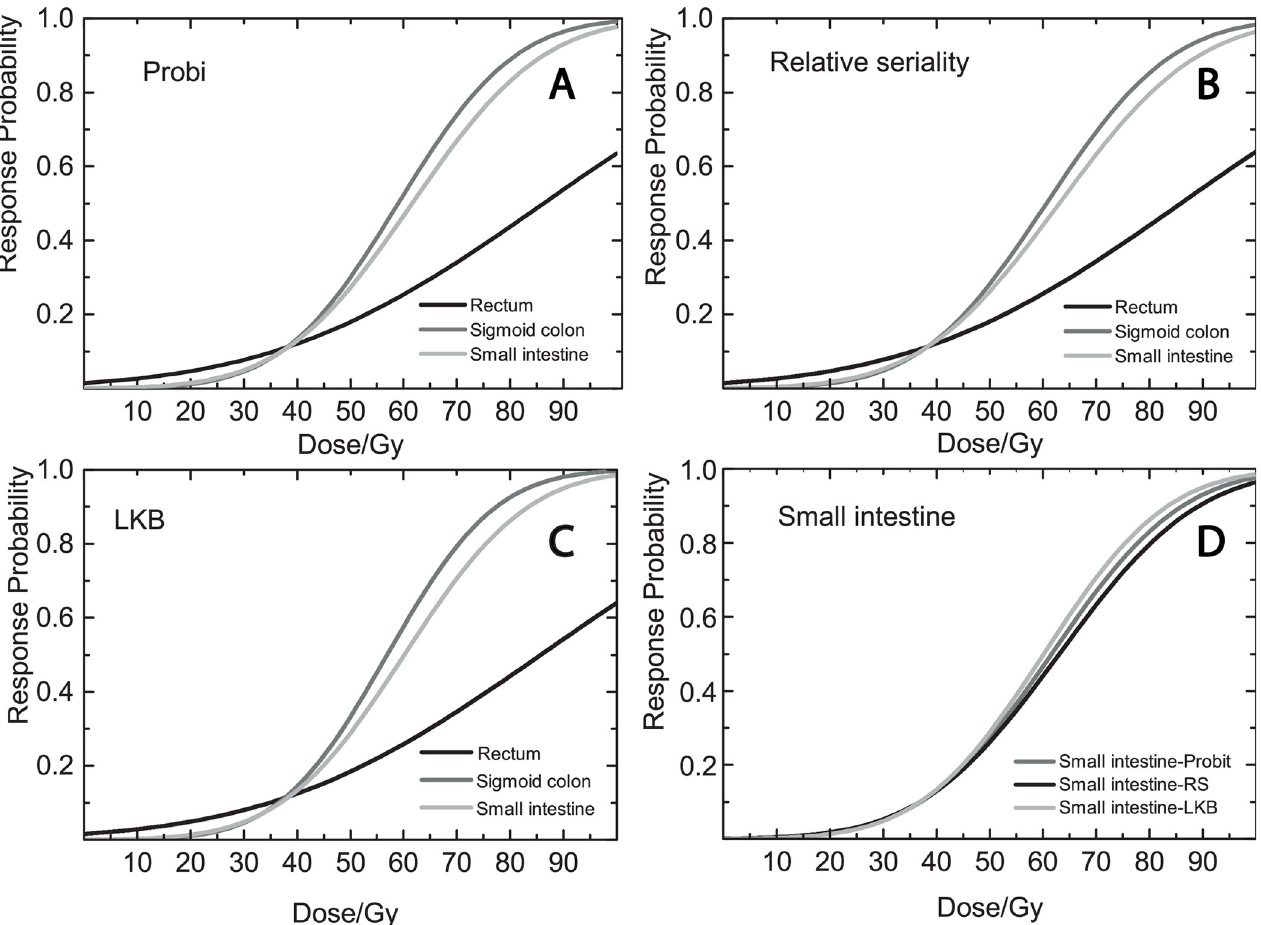
Fig 3. Dose-response curves. The figure illustrates the dose-response curves of mean dose to the: (a) rectum, (b) sigmoid colon and (c) small intestine using the Probit model, the Relative Seriality (RS) model, the LKB model. Panel d illustrates the mean dose to the small intestine for the Probit, Relative Seriality (RS) and LKB